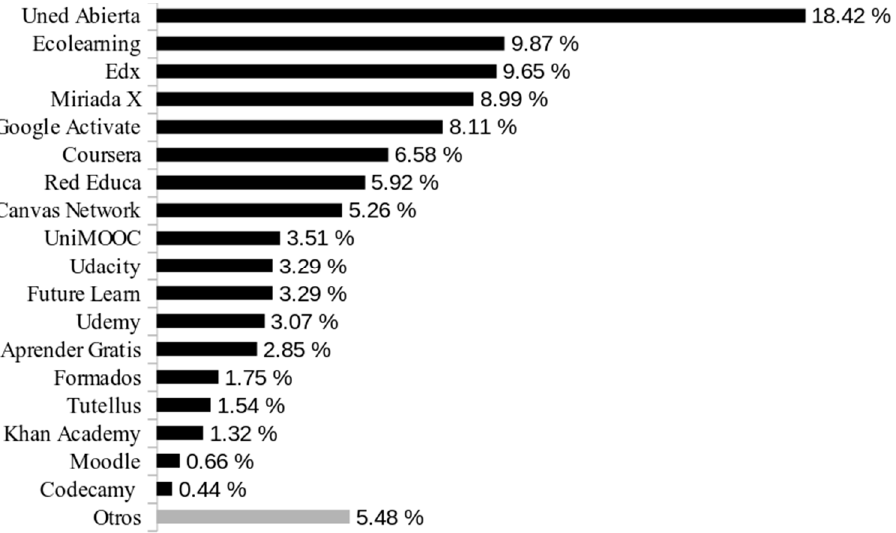
Figure 3. Most used platforms in the experiences with MOOC typologies.